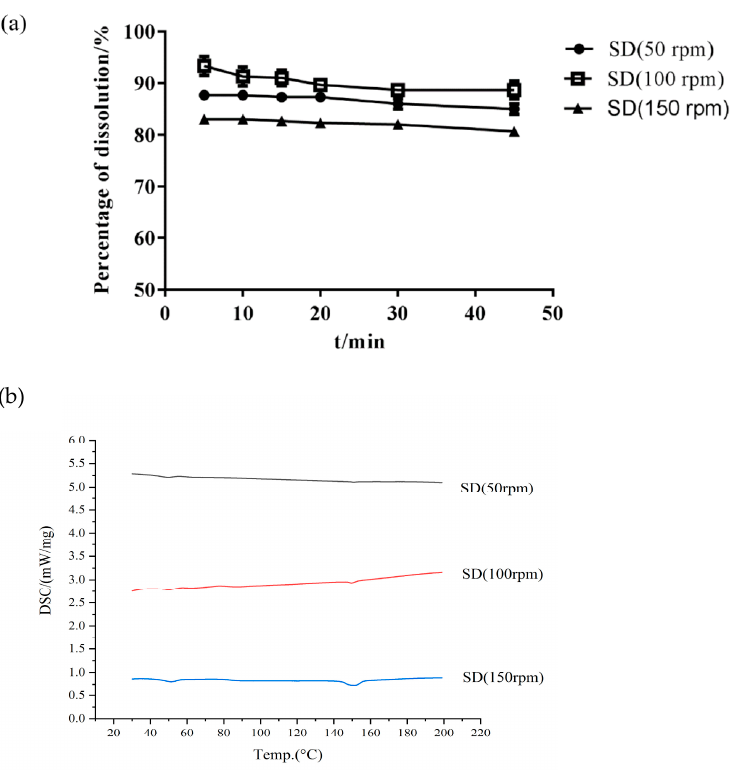
Figure 5. The dissolution of SD ( a ) and DSC curves ( b ) at different screw speeds.